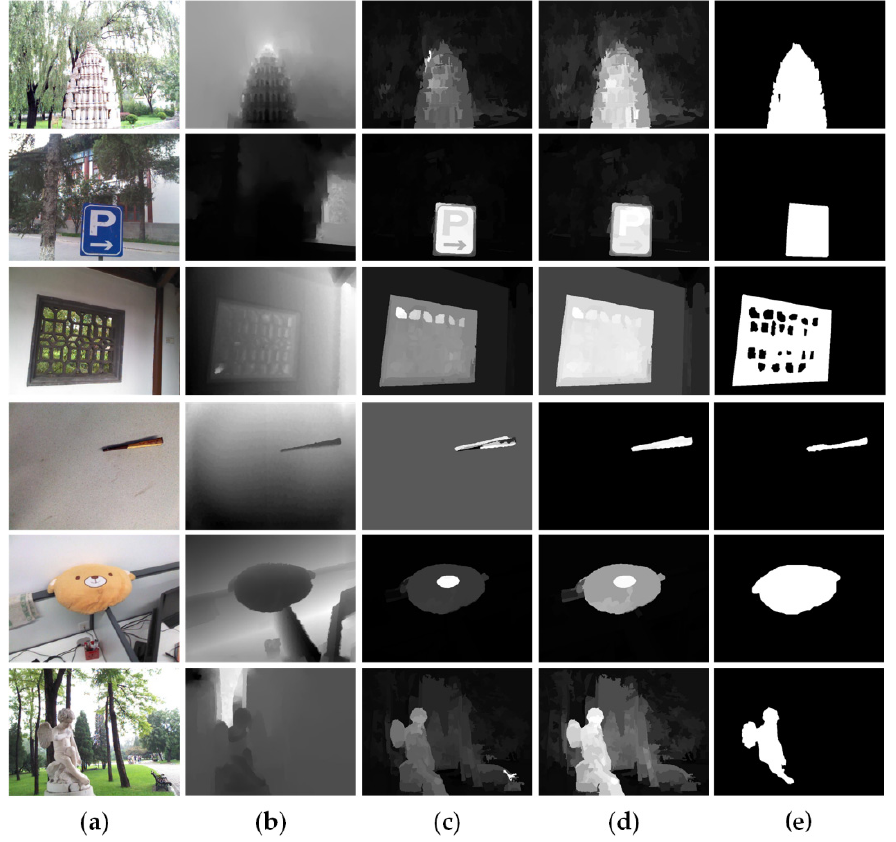
Figure 6. Visual comparisons of our proposed cross-mode multi-graph learning model (CMLM). ( a ) Original RGB images. ( b ) Original depth images. ( c ) Saliency maps based on single-mode multi- graph learning model (SMLM). ( d ) Saliency maps based on cross-modal multi-graph learning model (CMLM). ( e ) Ground truth.